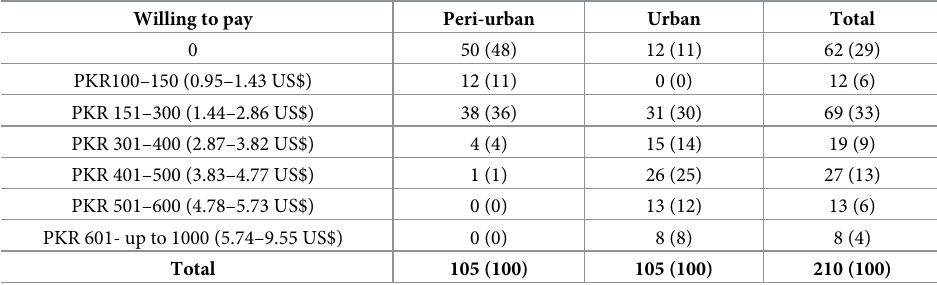
Figures in parentheses are the